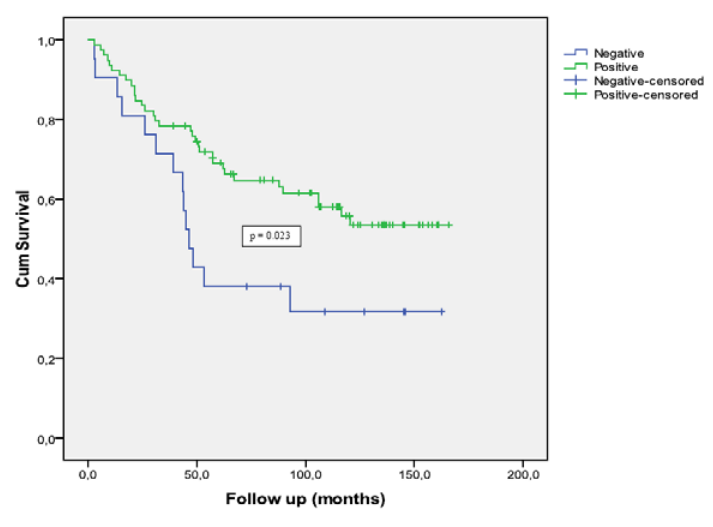
Figure 1 - Kaplan-Meier curve for biochemical recurrence free survival in 111 primary PC patients according to β 1 integrin expression. (Log-Rank test p =